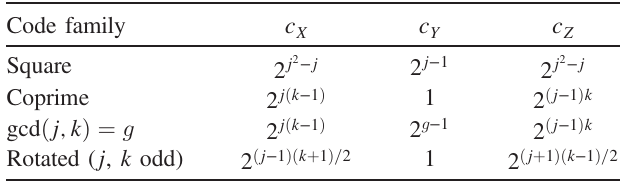
TABLE II. Counts of pure noise logical operators for j × k surface code families. ( c refers to the number of P -type logical P operators, where P ∈ f X; Y; Z g